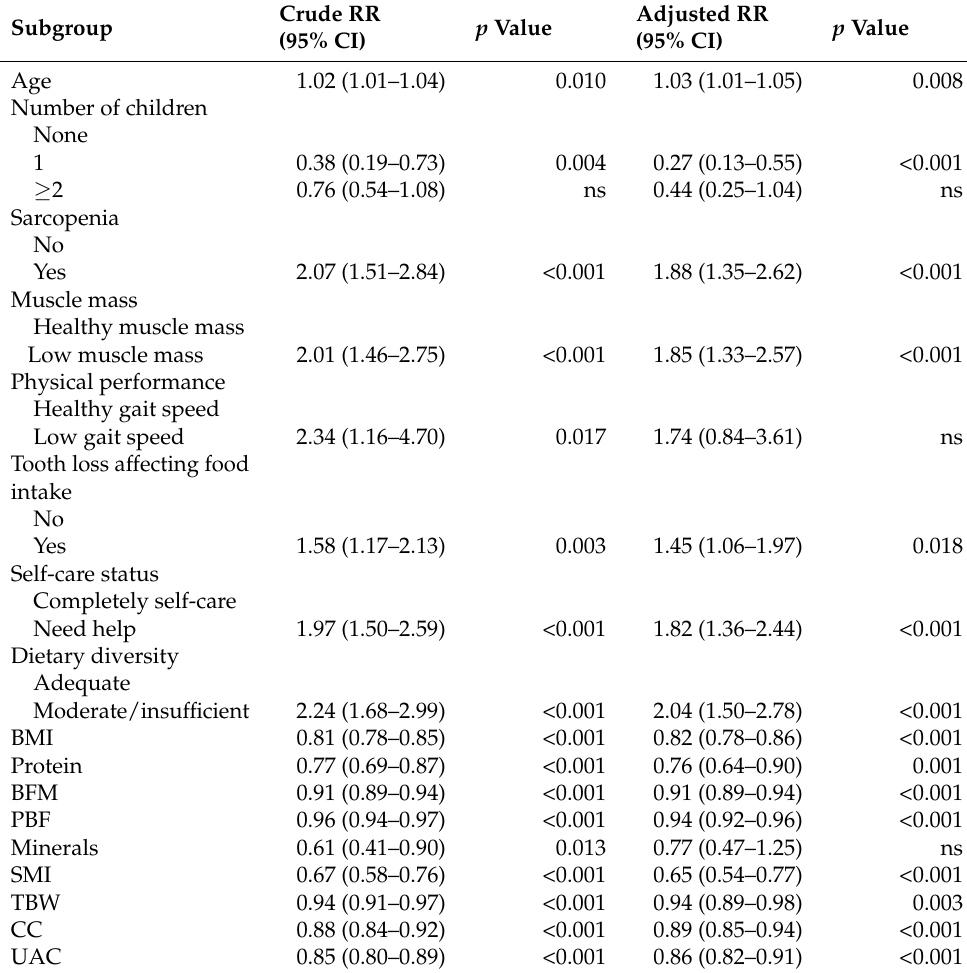
Table 2. Factors associated with nutritional risk: univariate and multiple Poisson regression